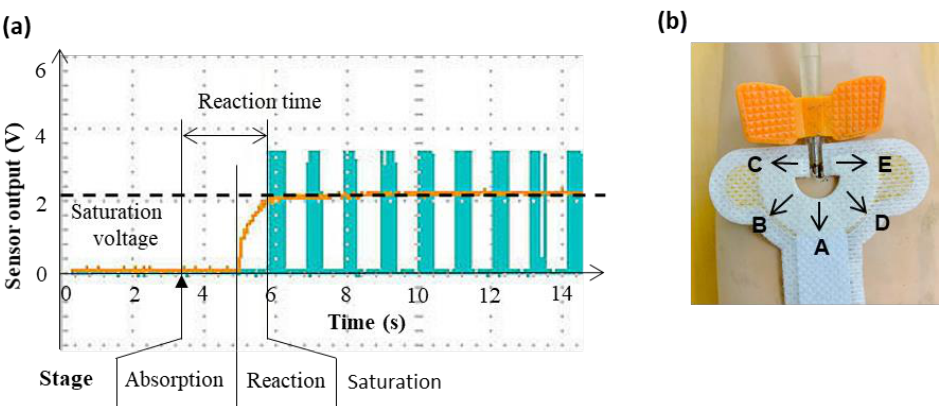
Figure 4. ( a ) Temporal profile of the voltage of the detection patch after injecting a single bolus of pig blood. Yellow line: the voltage from the detection patch. Cyan clusters of spikes: warning buzzers. Red dotted line: the saturation voltage. ( b ) The directions of blood ejection. A – E in ( b ) are 5 directions.